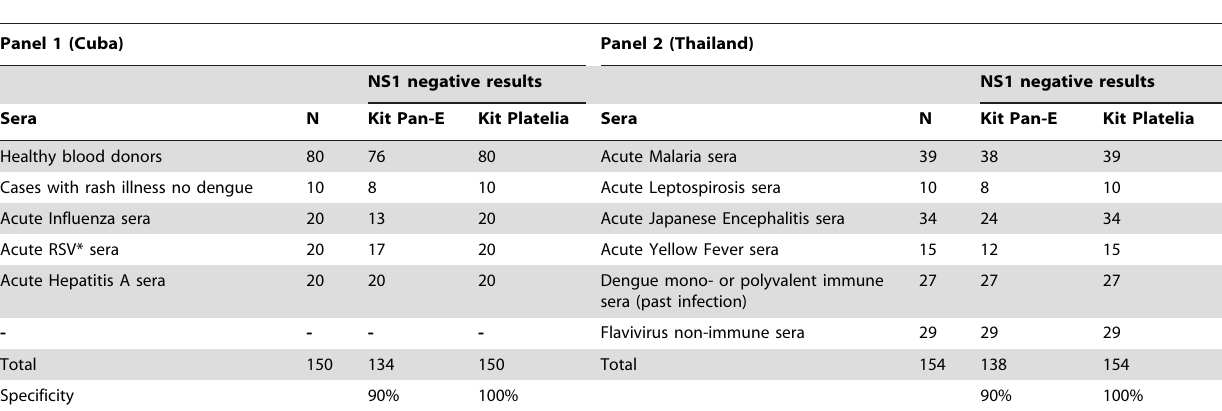
Table 7. NS1 results as determined by Kit Pan-E and Platelia assays in control sera panels.